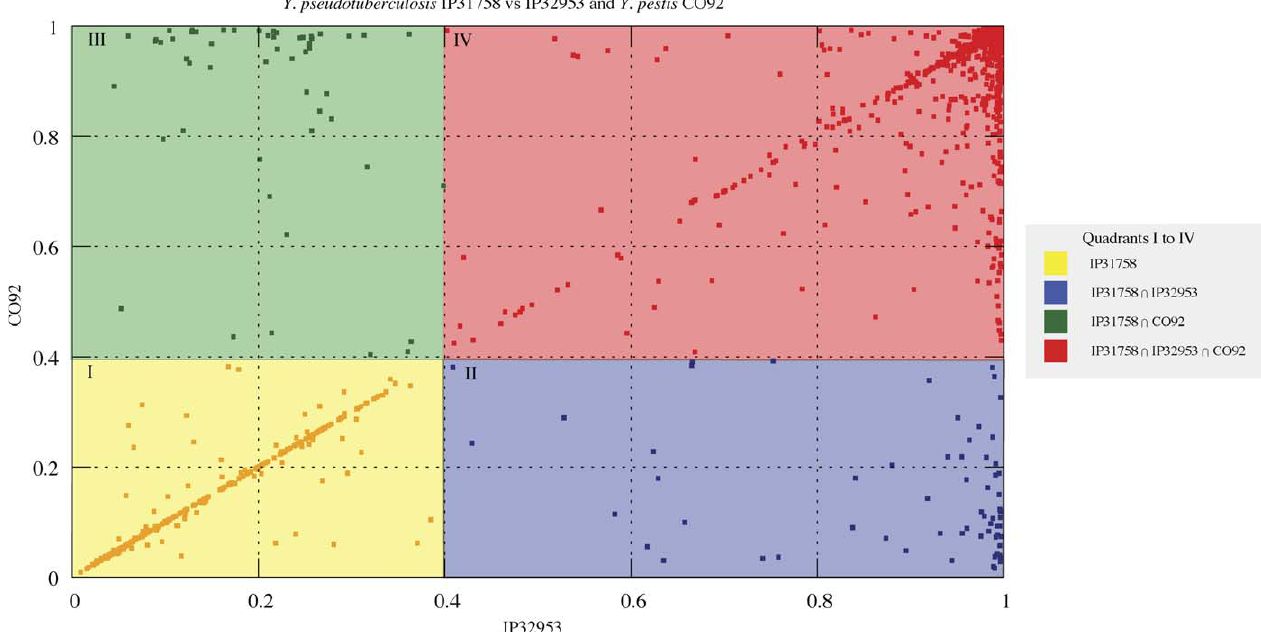
Figure 2. Genome Structure and Synteny (A) Y. pseudotuberculosis IP31758 compared to IP32953. (B) Y. pseudotuberculosis IP32953 compared to IP31758. (C) Y. pseudotuberculosis IP31758 compared to Y. pestis CO92. (D) Y. pseudotuberculosis IP31758 compared to Y. enterocolitica 8081. Each protein from the x -axis reference genome was queried using BLASTP for its presence in the y -axis query genome. For a match, the N-terminal coordinates of both proteins were plotted as x and y . The color represents the level of similarity of the match expressed by the BLAST score ratio [36]. Prophage insertions are highlighted in orange; the pathogenicity island YAPI IP31758 is highlighted in red; and HPI IP32953 is highlighted in purple.